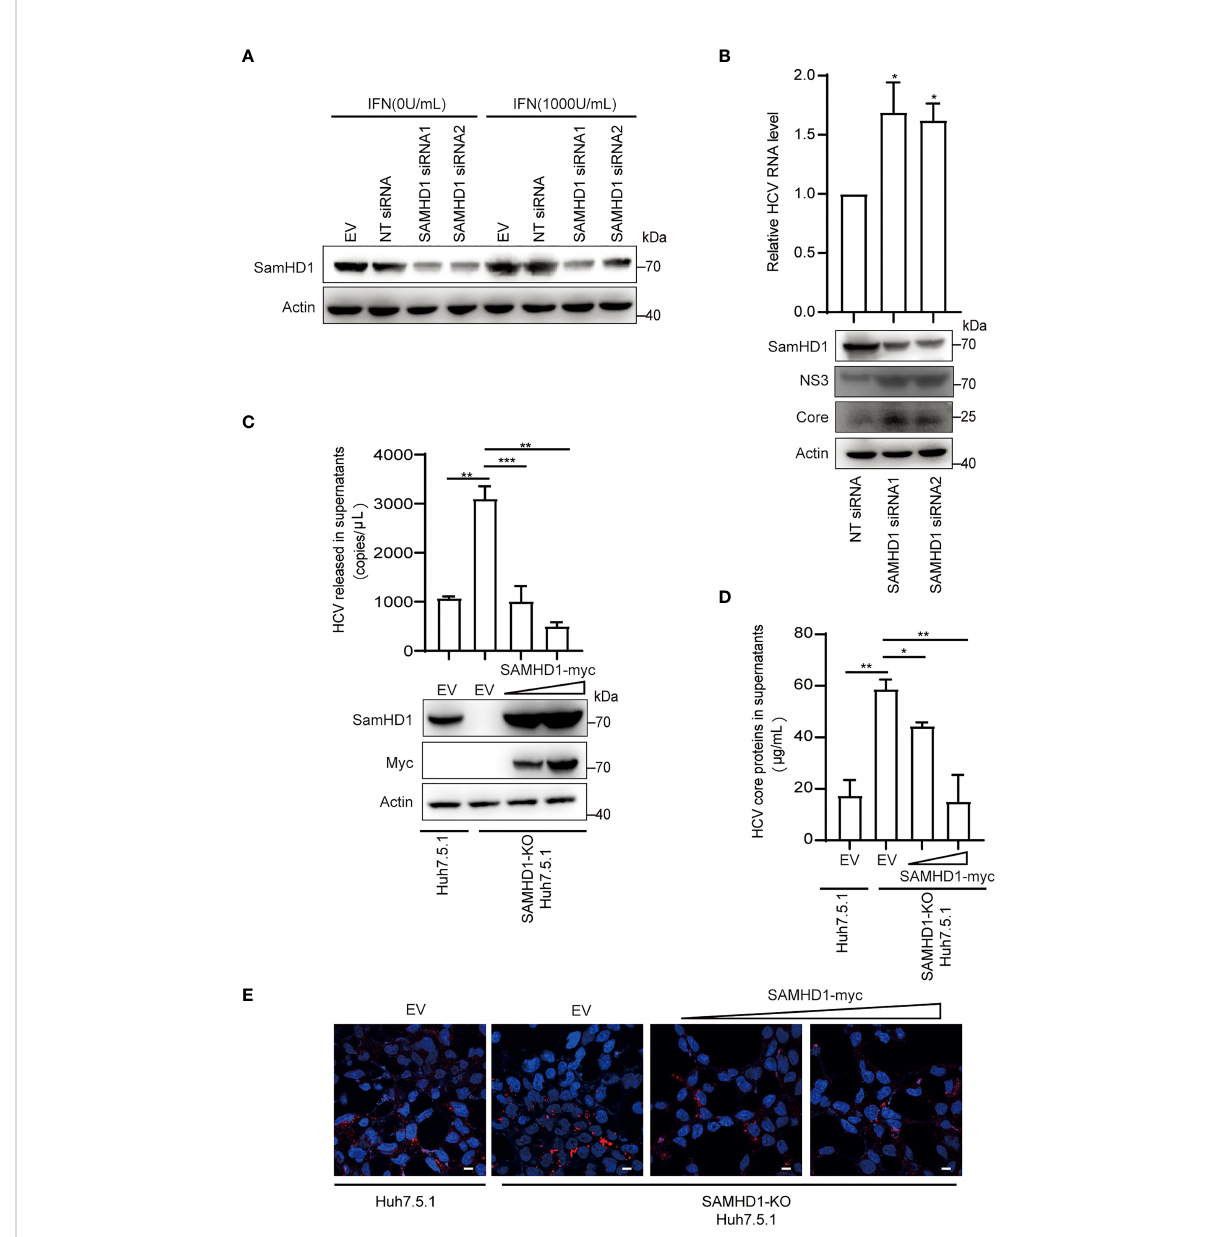
FIGURE 4 Endogenous SAMHD1 participates in HCV inhibition. (A) Huh7.5.1 cells were transfected with 50 pmol/ml siRNAs targeting SAMHD1 or non- targeting siRNA (NT siRNA) for 24 h, and followed by the addition of IFN- a 2b (1,000 U/ml) for another 48 h. Cell lysates were analyzed by Western blotting to determine the expression level of endogenous SAMHD1 protein. (B) Huh7 cells containing JFH1 subgenomic replicon were transfected with two different siRNAs targeting SAMHD1 for 48 h, and then a part of cells was harvested for measurement of HCV structural or non-structural proteins (core and NS3) by Western blotting. The other part of the cells was applied for total RNA extraction and qRT-PCR analysis. Values are shown as means ± SD ( n = 3) and the value of the control group is set to 1. (C – E) A SAMHD1 knockout Huh7.5.1 cell line constructed by CRISPR-Cas9 technology was used to transfect plasmid expressing SAMHD1 and incubated with JFH1 HCVcc for an additional 48 h; normal Huh7.5.1 cells and pcDNA4.0 were respectively treated as cell control and plasmid control, and HCV RNA and HCV core proteins in culture medium were quanti fi ed by qRT-PCR (C) and ELISA (D) . Data are representative of three independent experiments and shown as a histogram. Expression of endogenous and extrogenous SAMHD1 proteins was veri fi ed by Western blotting. Cell culture medium containing progeny virus was incubated with naïve Huh7.5.1 cells for an additional 72 h and detected HCV core proteins by immuno fl uorescence staining. Representative images are shown (cells > 10), Bars, 5 m m (E) . *P<0.05; **P<0.01, and